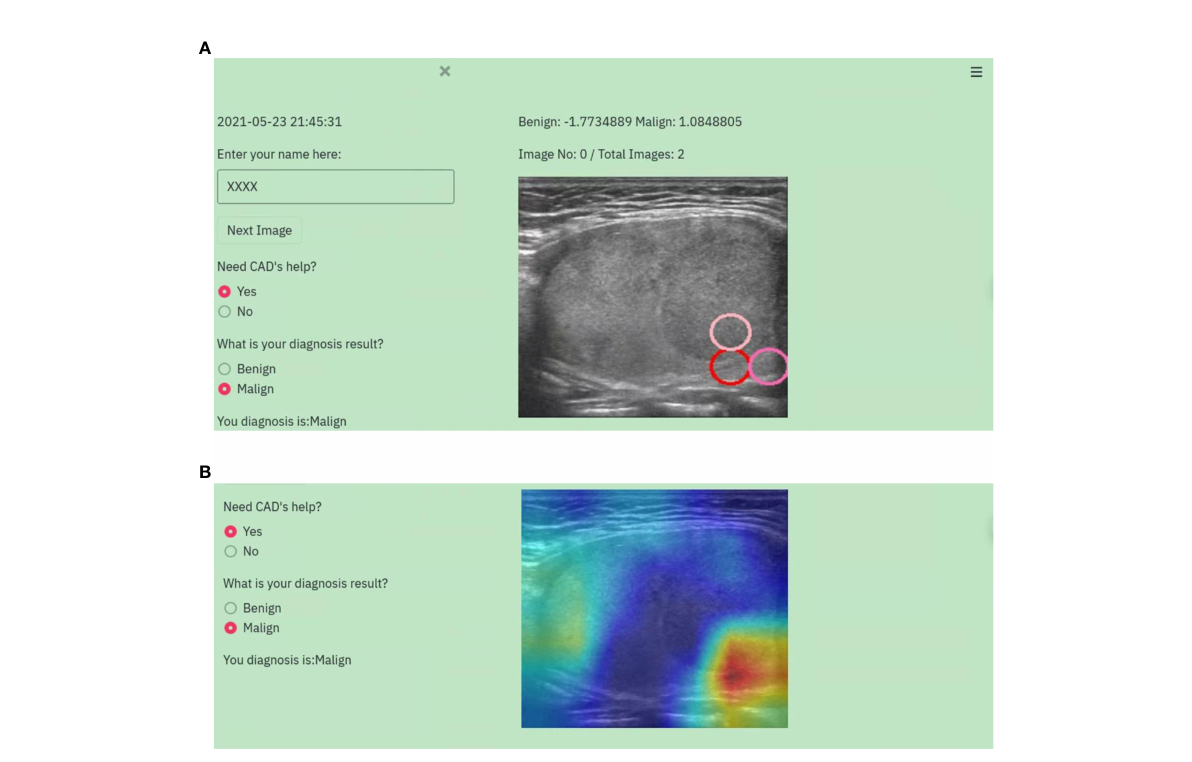
FIGURE 2 An example of the diagnosis procedure with the WGUI. (A) Diagnosis interface with the diagnosis results from the CAD. (B) Diagnosis interface with Gad-CAM